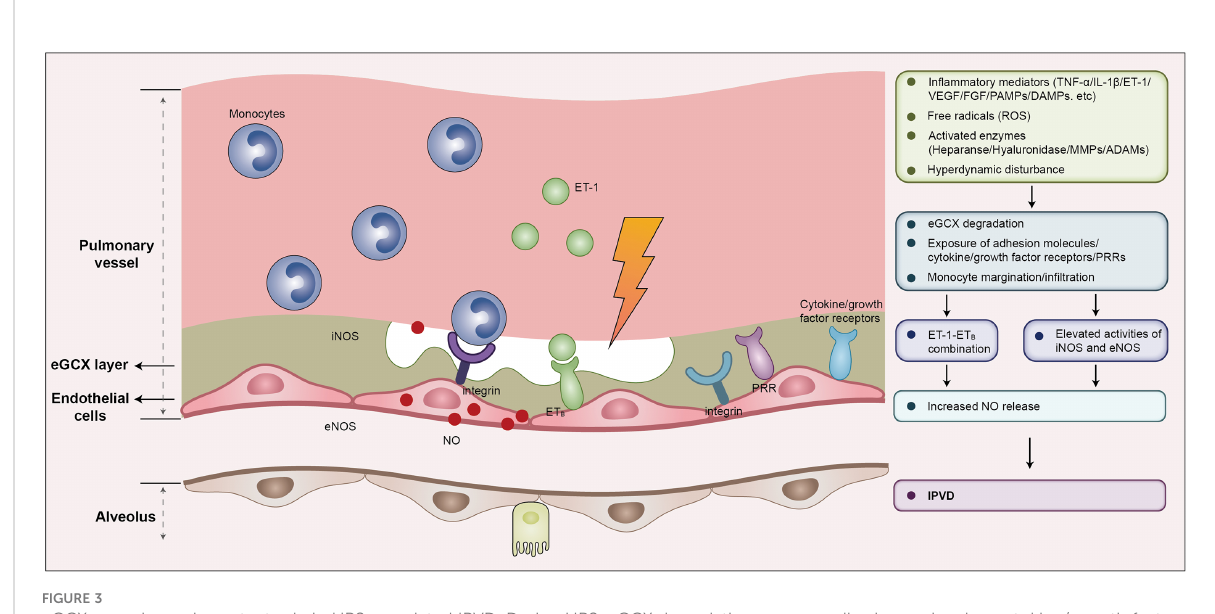
FIGURE 3 eGCX may play an important role in HPS associated IPVD. During HPS, eGCX degradation exposes adhesion molecules, cytokine/growth factor receptors, and pattern recognition receptors that facilitate the processes of monocyte migration and in fi ltration, and the interaction of monocytes and endothelial cells, resulting in increased expression of iNOS and eNOS, and the consequent release of NO, the major contributor of IPVD. Abbreviations: eGCX, endothelial glycocalyx; IPVD, intrapulmonary vascular dilation; iNOS, inducible nitric oxide synthase; eNOS, endothelial nitric oxide synthase; NO, nitric oxide; ET-1, endothelin-1; ETB, type B endothelin receptor; VEGF, vascular endothelial growth factor; FGF, fi broblast growth factor; ROS, reactive oxygen species; TNF- a , tumor necrosis factor a ; IL-1 b , interleukin-1 b ; PAMPs, pathogen associated molecular patterns; DAMPs, damage associated molecular patterns; PRRs, pattern recognition receptors; MMPs, matrix metalloproteinases; ADAMs, a disintegrin and